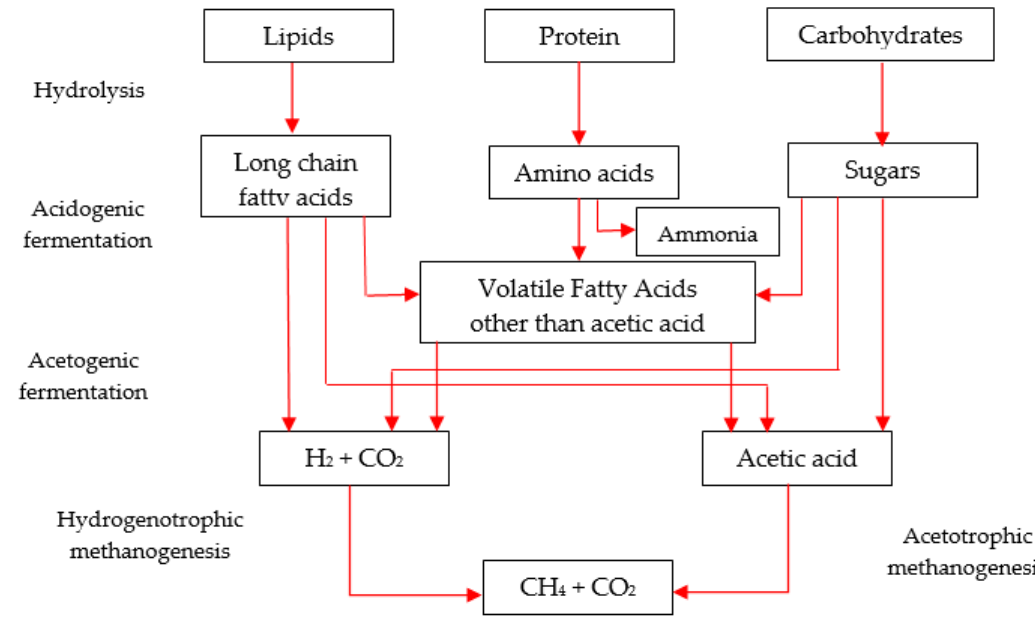
Figure 3. Methanogenic fermentation pathways for anaerobic wastewater treatment (inspired by